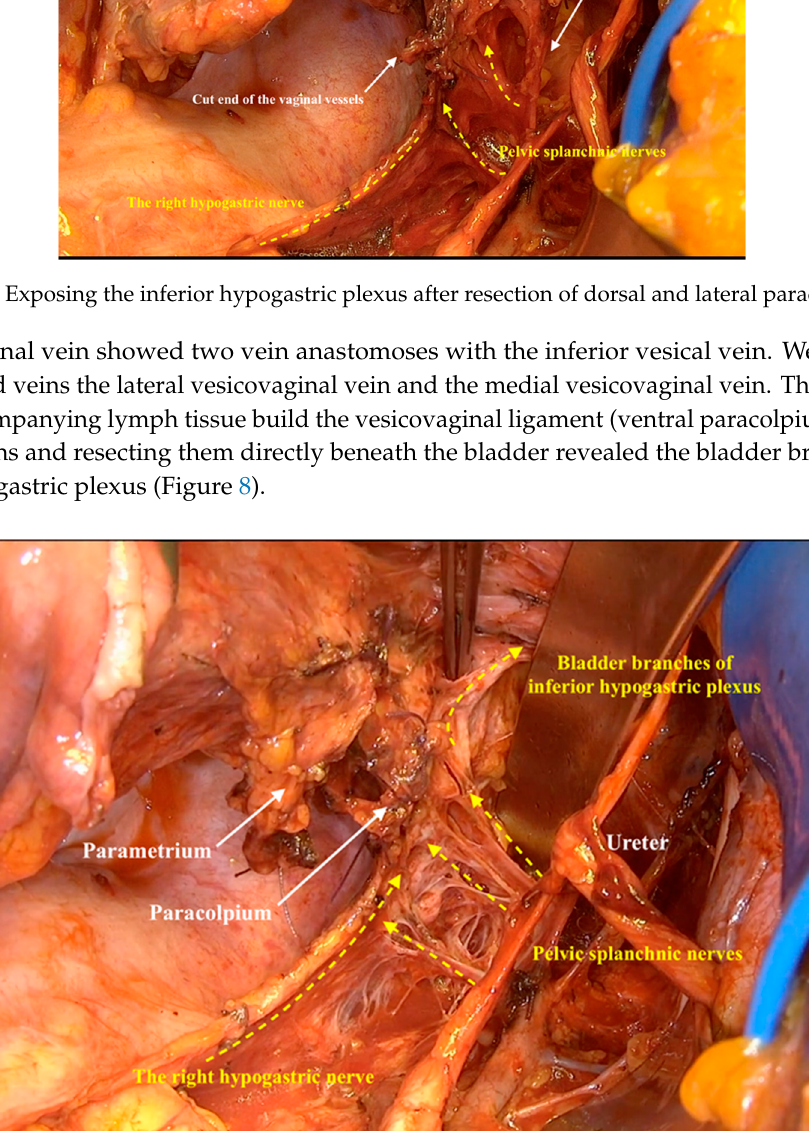
Figure 6. ( a ) The adherent localization between lateral and ventral paracolpium and the pelvic splanchnic nerves and inferior hypogastric plexus. ( b ) The vascular anastomoses between vaginal vessels and inferior vesical vessels in the ventral paracolpium.